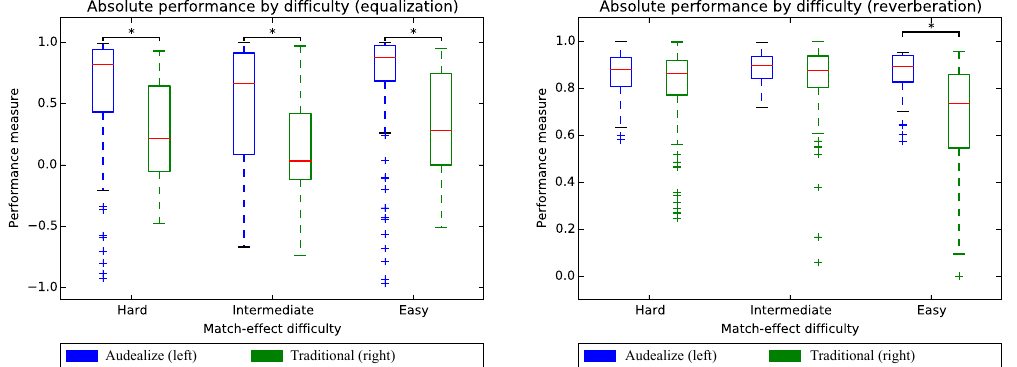
Figure 7. Match-effect test: absolute performance for equalization ( right ) and reverberation ( left ) broken down by difficulty. The * indicates statistical significance between distributions at a p -value < 0.01. We find significant difference in favor of the word-map interface used in Audealize in the easy task for reverberation and in all tasks for equalization. N = 108 for each box plot. Higher is better in each plot. Figure created by the